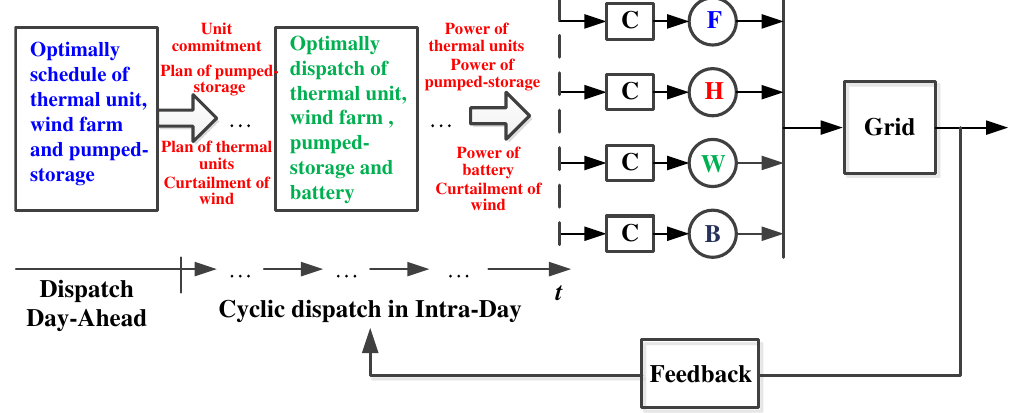
Fig. 2 Coordinate framework of pumped-storage and